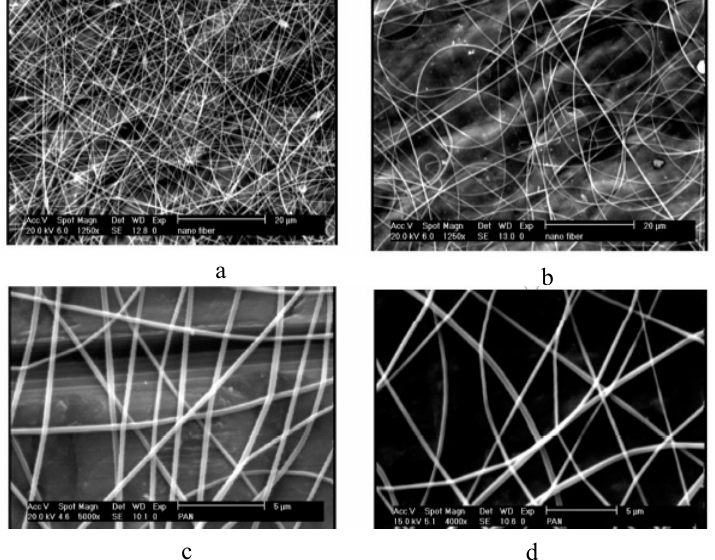
Figure 3. SEM image of (a)(c) the raw nano fiber and (b)(d) modified PAN nano